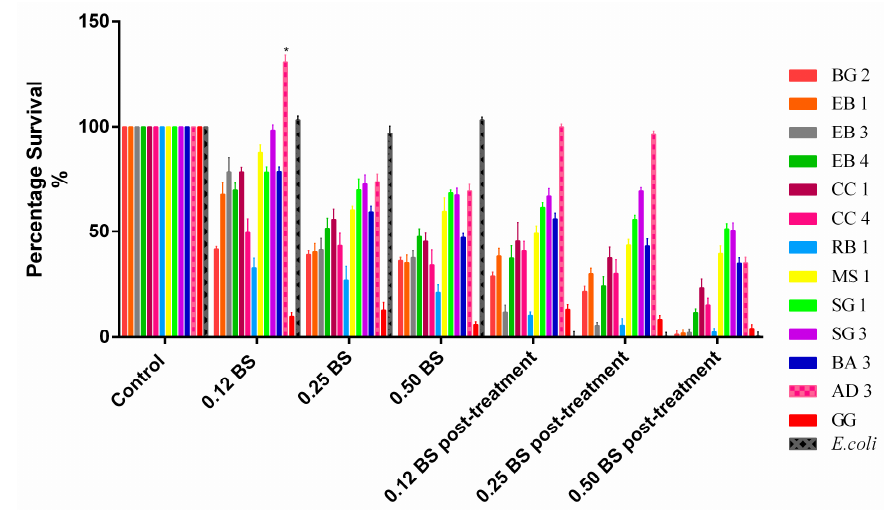
Figure 2. Percentage of survival at different concentrations of bile salts before and after exposure to acid pH. Data are showed as mean ± SD; p values were calculated by applying one-way ANOVA with Bonferroni correction for multiple comparisons. Significance vs. control * p < 0.05.